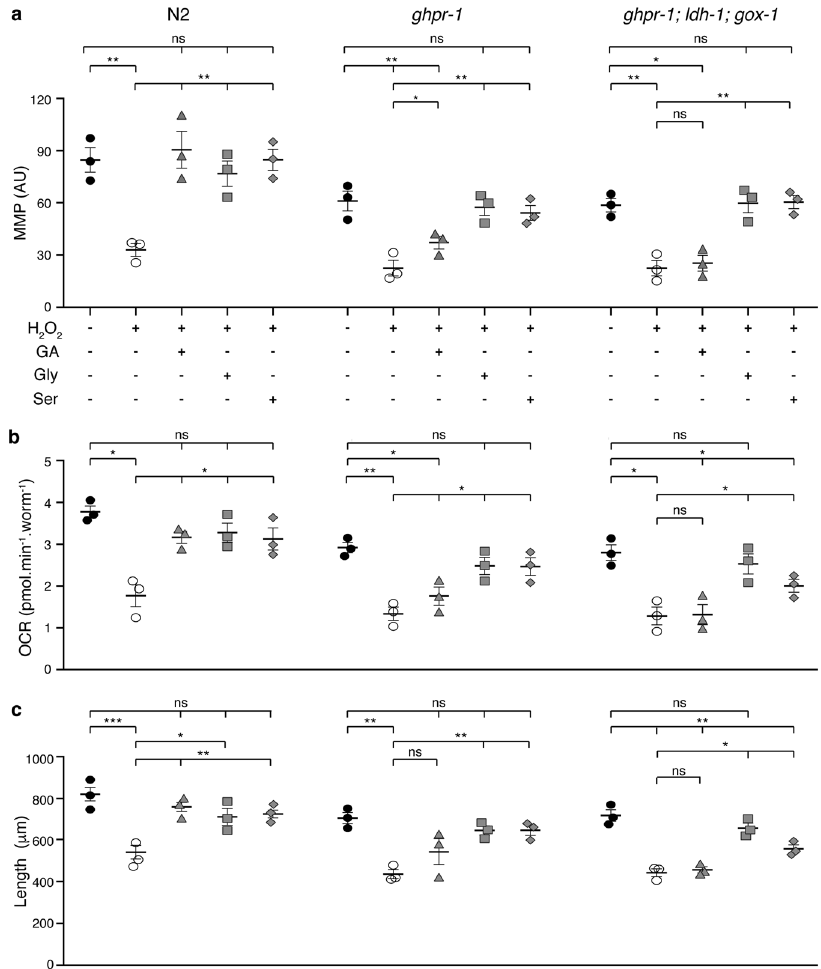
Fig. 5 Glycine and L -serine supplementation rescue mitochondrial function and developmental rate of glycolate-oxidation-de fi cient worms. Mitochondrial membrane potential ( a ), respiration rates ( b ), and size ( c ) of wild type (N2) or mutant strains ( ghpr − 1 and ghpr-1, gox-1, ldh-1 ) exposed to 100 mM H 2 O 2 and supplemented, with 10 mM glycolate, 100 μ M glycine, or 500 μ M L -serine, as indicated, as indicated. Measurements were carried out as described in Fig. 2. Error bars represent standard error of the mean ( n =